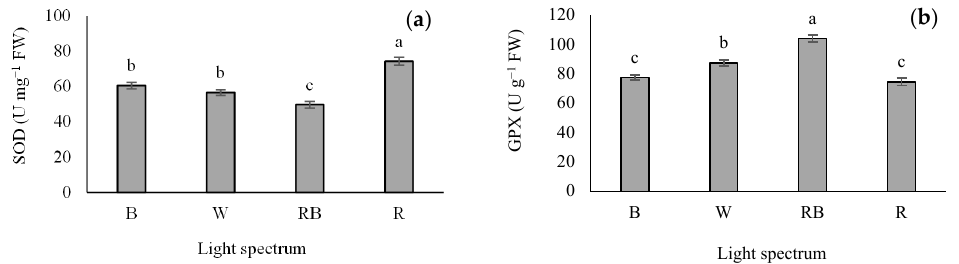
Figure 7. Superoxide dismutase (SOD; ( a )) and guaiacol peroxidase (GPX; ( b )) activity in grafted tomato seedlings exposed to different light qualities (including white (W; 35% B, 49% intermediate spectra, 16% R) light as control, blue (B), red (R), and a combination of red (68%) and blue (RB), (see the correspondence spectrum in Figure 1)), with 75 ± 5 µmol m − 2 s − 1 PPFD for 20 days. Columns with the same letters are not significantly different at p ≤ 0.05, according to Duncan’s multiple range tests. Bars represent the mean value of three replications ± SEM.